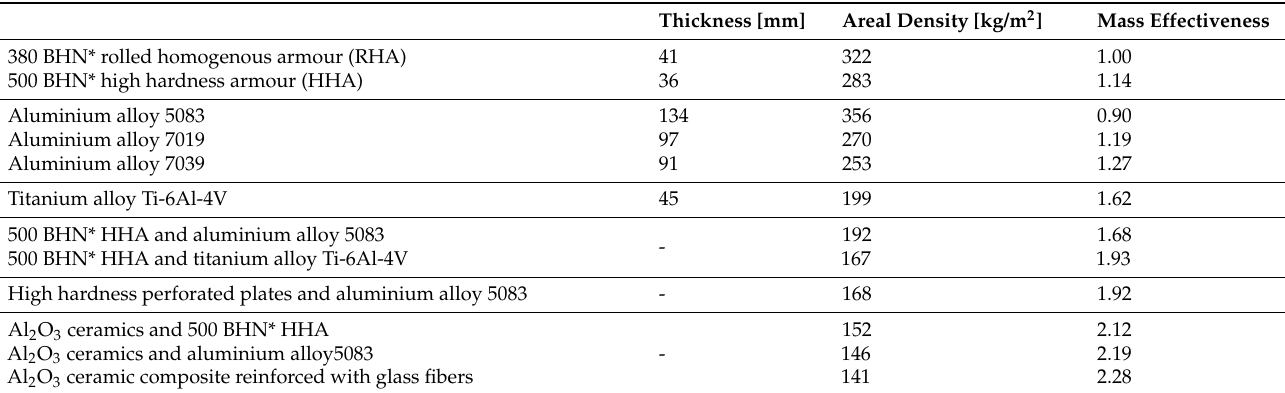
Figure 1. Passive armour materials and types. Table 1. Typical thicknesses, areal densities and mass effectiveness of various types of armour [7].